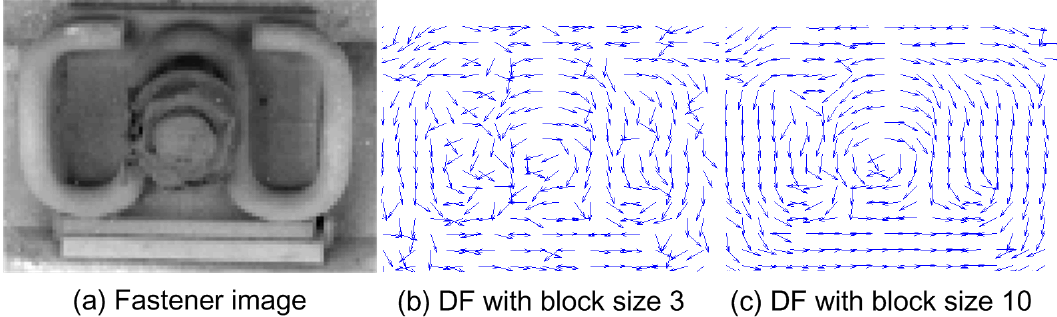
Figure 6. Image of the fastener and its DF. ( a ) Original fastener image; ( b ) DF with a block size of 3 × 3 pixels; and ( c ) DF with a block size of 10 × 10